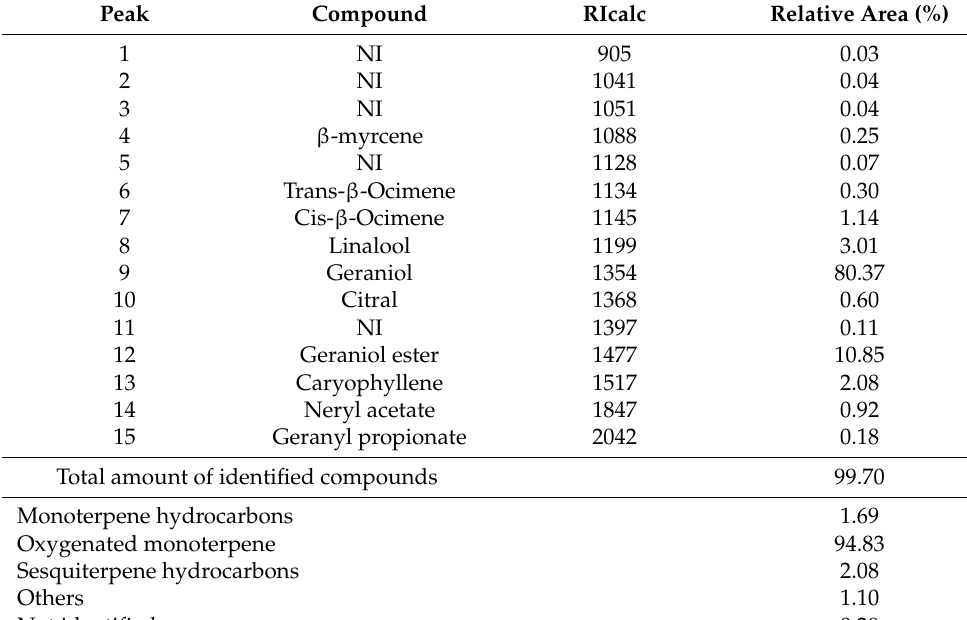
Table 1. Chemical composition of palmarosa ( Cymbopogon martini ) essential